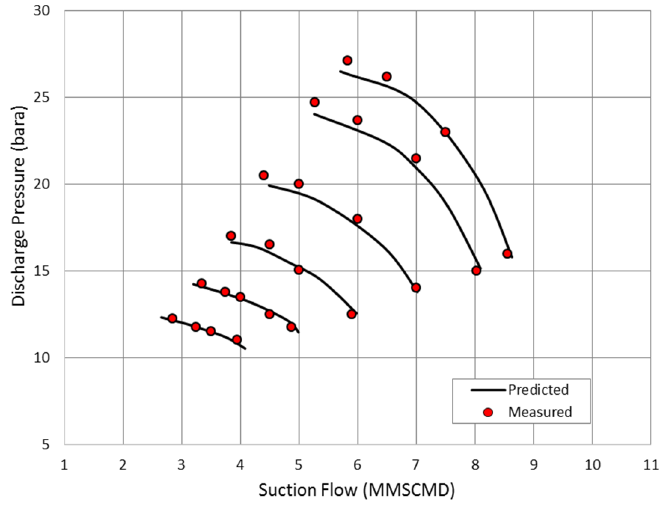
Figure 4. Comparison between the predicted and measured discharge pressure.